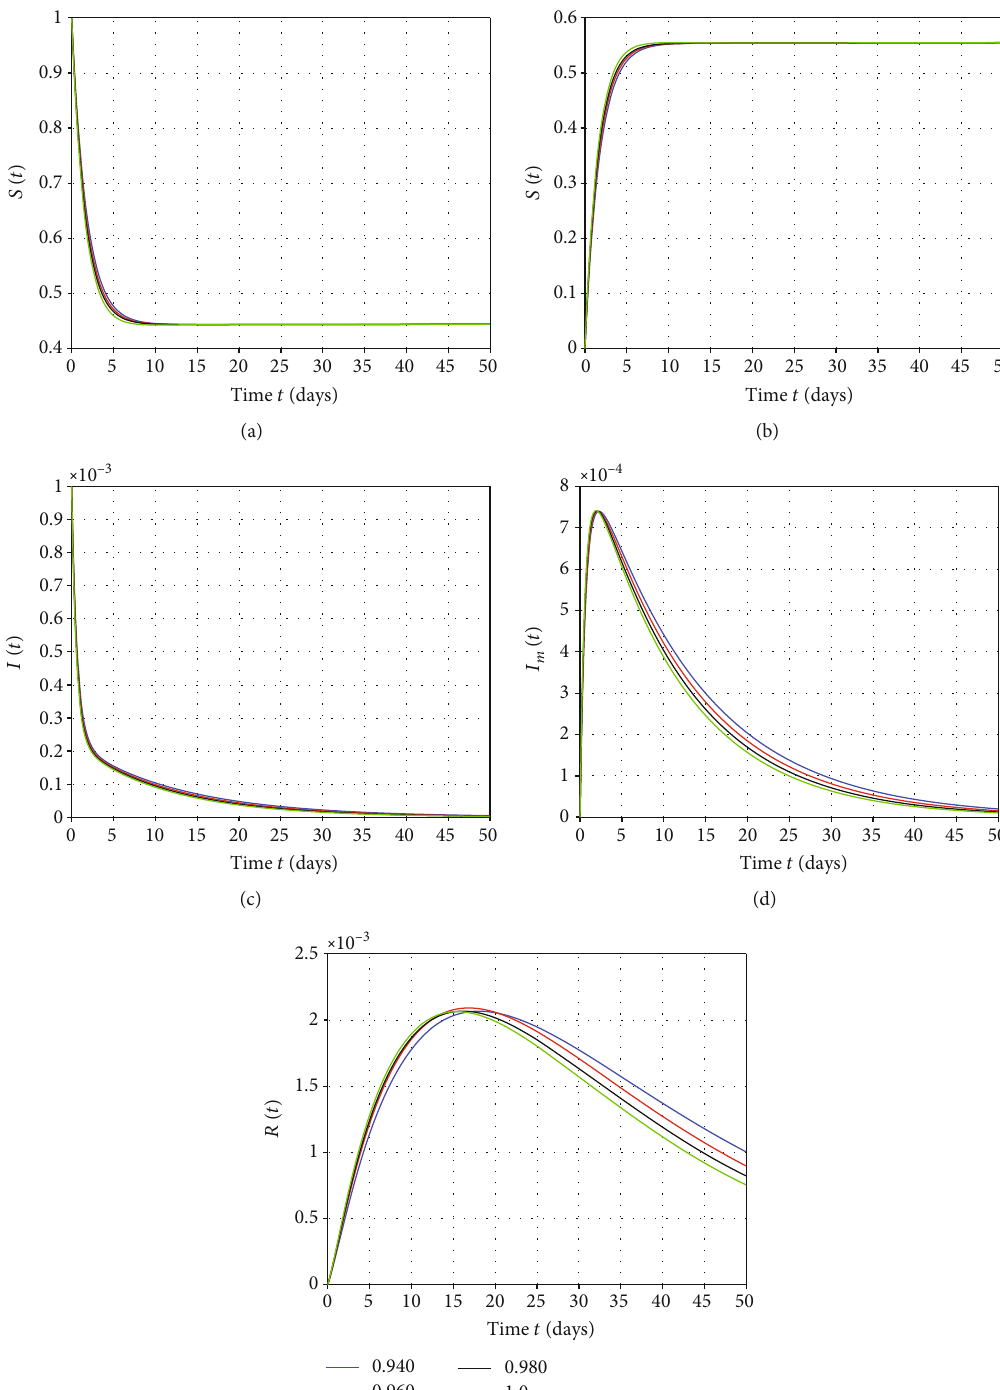
Figure 3: Numerical solution of system (10) for κ = 0 : 5 and di ff erent values of ϵ fractional